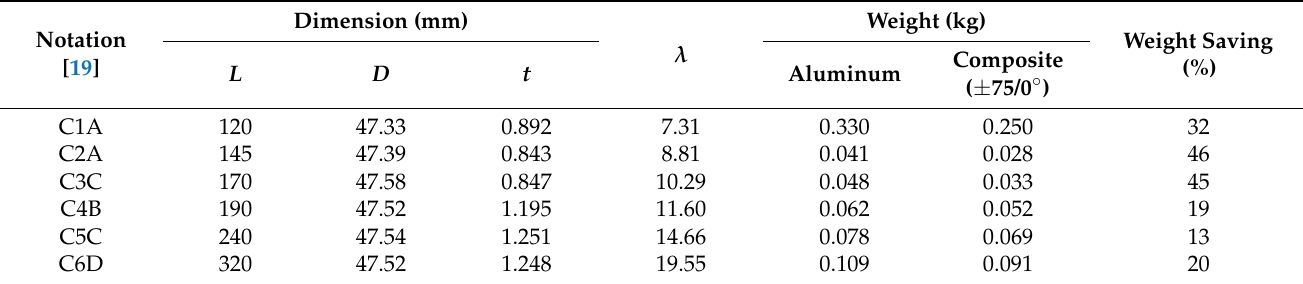
Table 8. Obtained thickness and weight information.